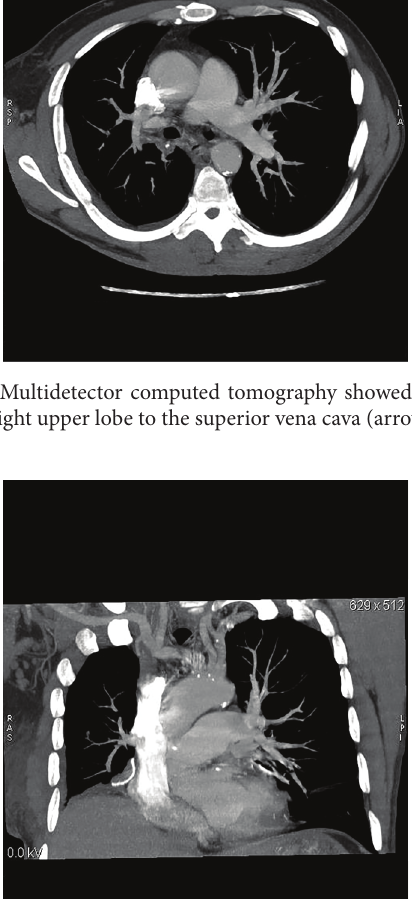
the anomalous vein or veins are often connected to the right atrium or the superior vena cava